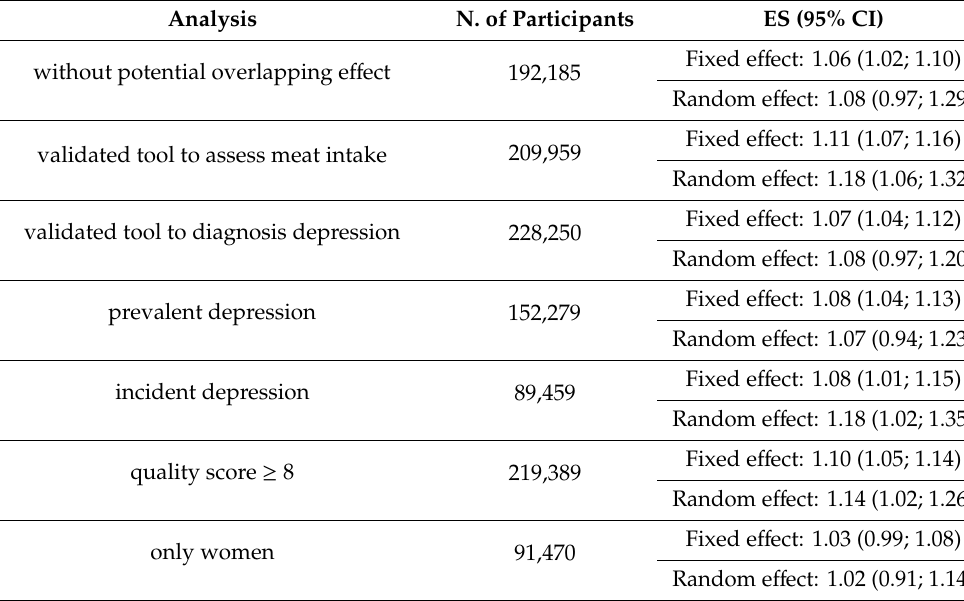
Table 3. Results of sensitivity and subgroup